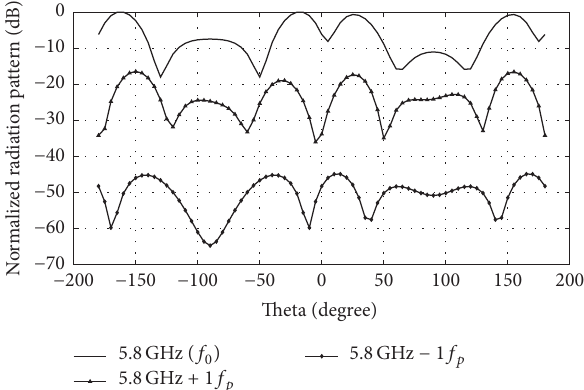
Figure 9: Radiation pattern at centre frequency 5.8 Ghz and